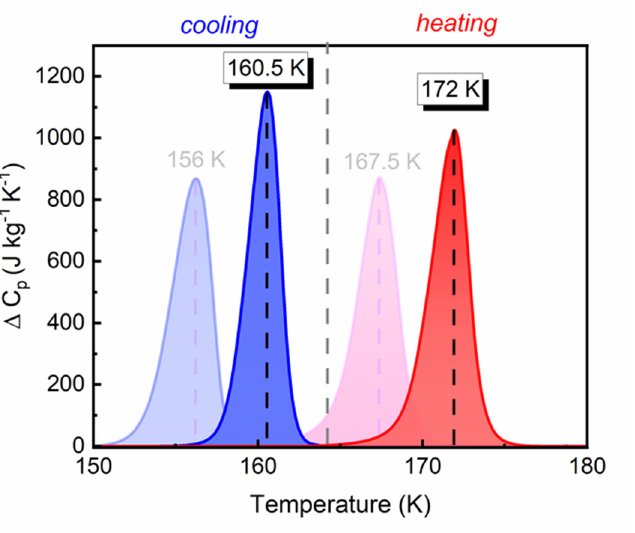
Figure 2. The changes in heat capacity to the phase transition in DMAZnD and DMAZnF (light background) [26] measured in cooling and heating